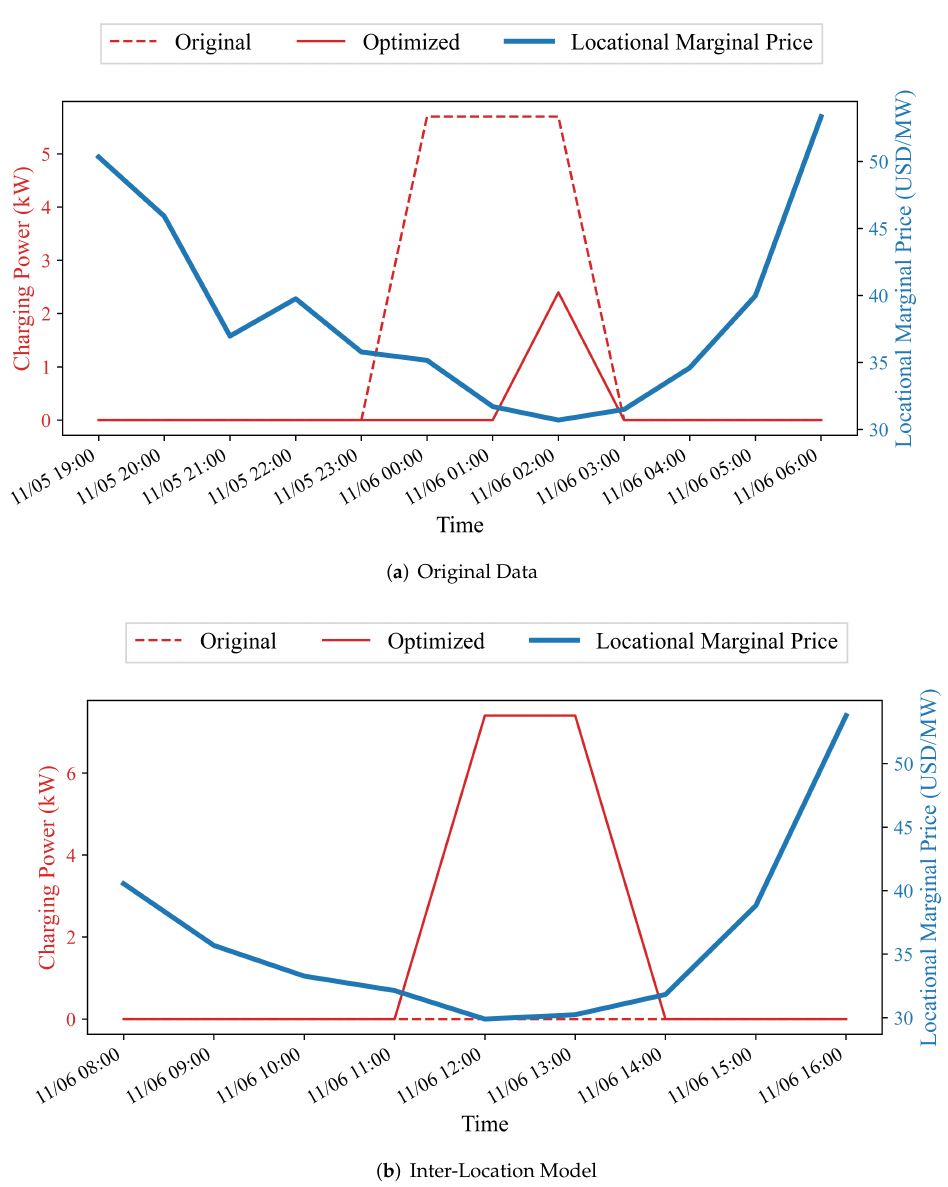
Figure 6. Sample trajectories of charging powers in the original data and the inter-location model